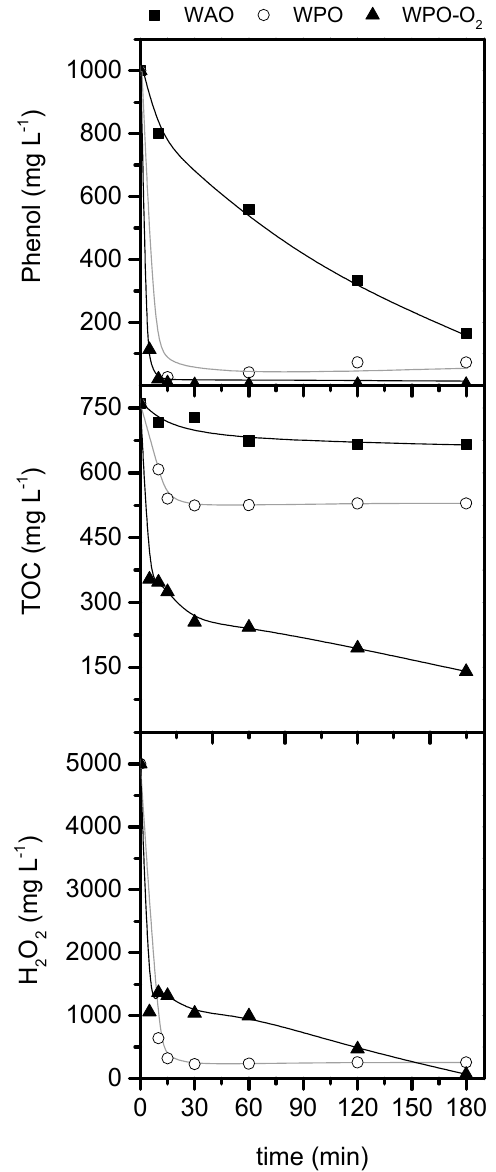
time (min) Figure 1. Temporal concentration profiles of H 2 O 2 , phenol and TOC upon the treatment of phenol by WAO, WPO and WPO-O 2 processes. Operating conditions: [Phenol] 0 = 1000 mg L − 1 , [H 2 O 2 ] 0 = 5000 mg L − 1 , P O2 = 8 bar (92 N mL O2 min − 1 ), T = 127 ◦ C and natural pH 0